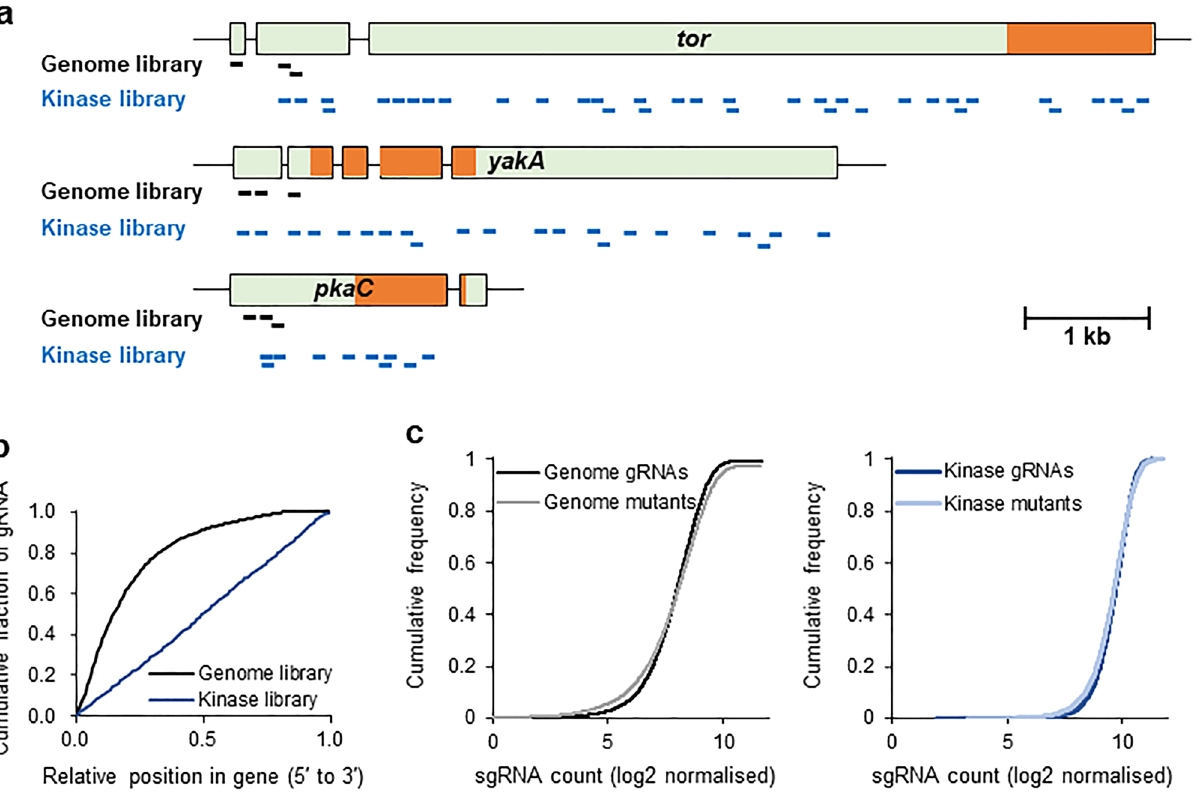
Figure 2. Generation of a genome-wide and kinase sgRNA plasmid library. ( a ) Target gRNA positions in the genome-wide and kinase libraries. Target sequences in genome library were designed within 400 bp of the start codon, while kinase libraries were designed with five gRNAs per 1 kb of each gene. Three representative genes are shown. The kinase domain of each gene is indicated by an orange box. ( b ) Distribution of designed gRNAs in genes. ( c ) Deep-sequencing analysis of the gRNAs in plasmid libraries and genome-wide (left) and kinase (right) mutant